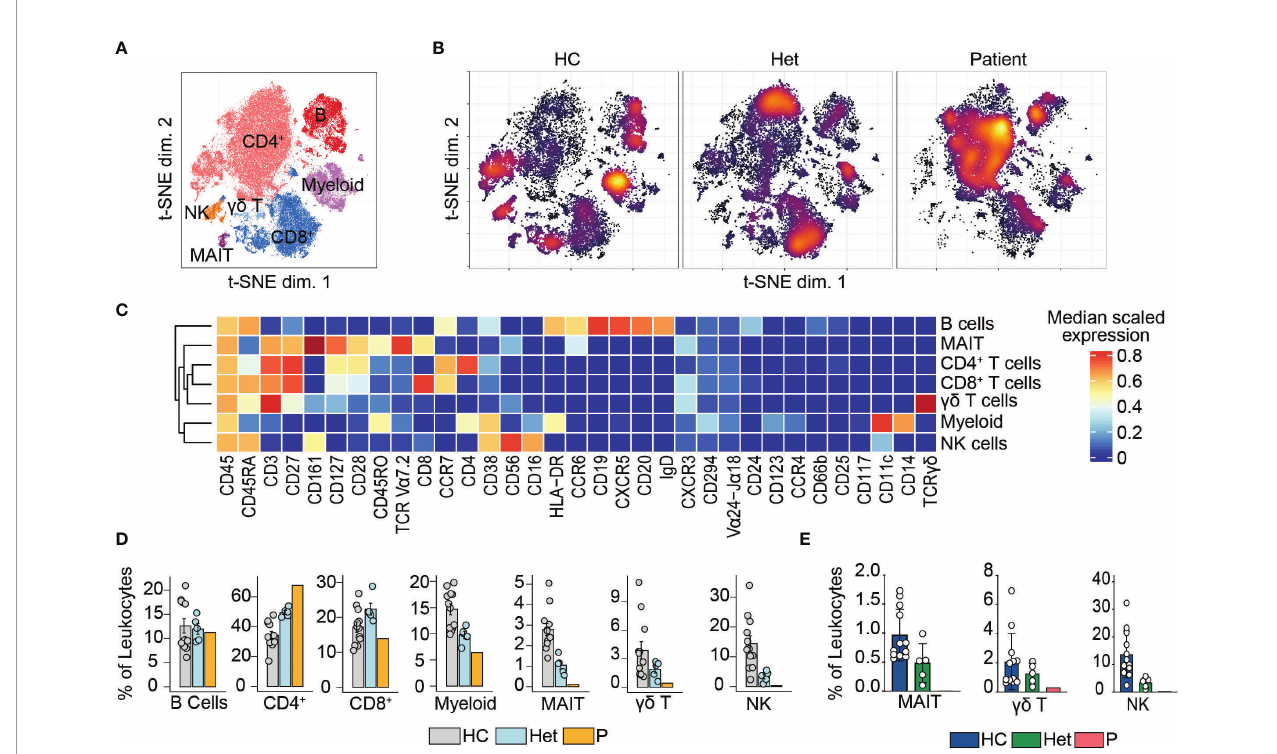
FIGURE 2 | Leukocyte immunophenotyping. (A) Dimensional reduction by t-SNE of the 33 markers used for immunophenotyping by mass cytometry. Each color represents a cell population obtained by manual clustering according to their surface marker expression. 50,000 cells from healthy controls (HC), heterozygous carriers (Het), and the patient are represented. (B) Density t-SNE showing the distribution of leukocytes in healthy control (HC), heterozygous carrier (Het), and the patient . (C) Median expression heatmap of the markers shown under the graph, for the populations shown in (A, D) Frequencies of the populations highlighted in (A) as a percentage of leukocytes. (E) Frequencies of MAIT, gd T, and natural killer cells in healthy controls (HC), heterozygote carrier (Het), and patient as a percentage of leukocytes obtained by manual gating in FlowJo shown in Figure S2